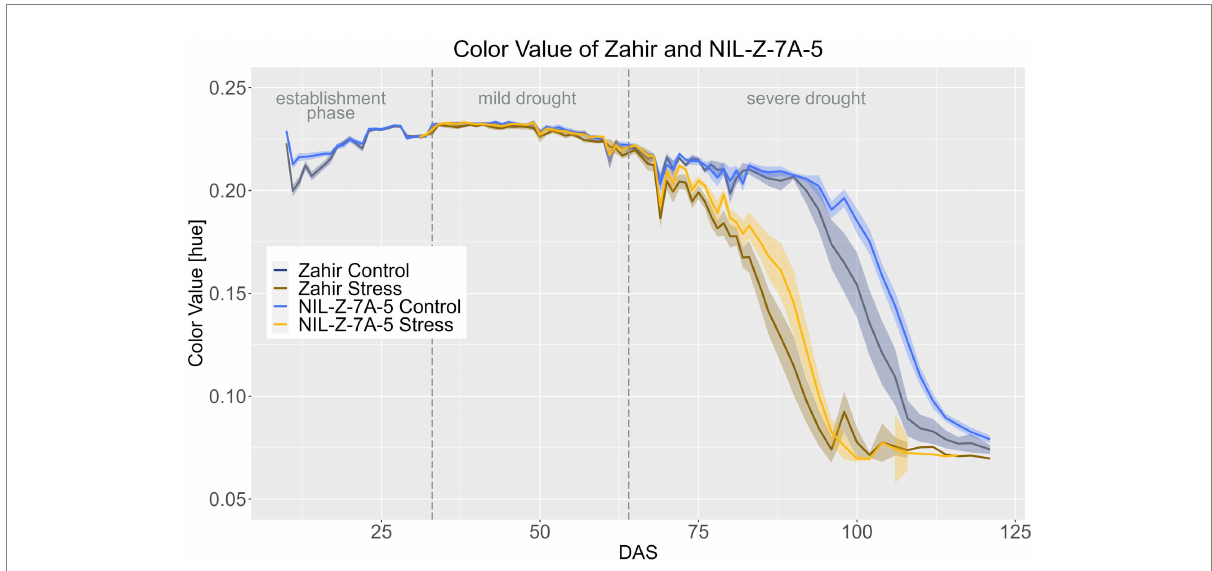
FIGURE 8 Color value of Zahir and NIL-Z-7A-5 based on the calculated BLUEs values. DAS, days after sowing; BBCH55, heading day. The last DAS for each genotype was chosen for the DAS where the last time 60% of the plants were imaged (as mature plants were taken off subsequently). The shadows describe the confidence interval; as long as the shadows of the individual lines do not overlap, the significance level of a = 0.05 is not reached and therefore a significant difference